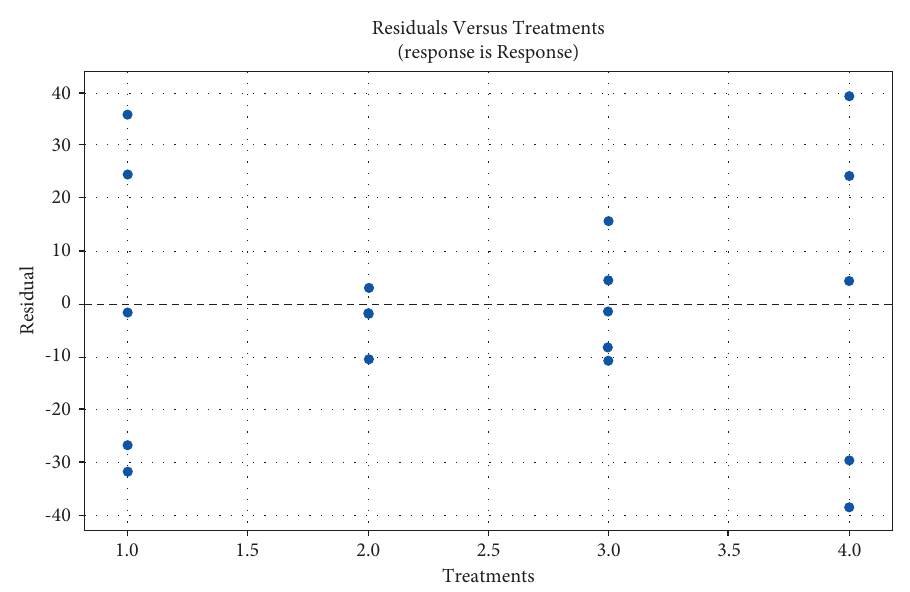
Figure 6: Residuals versus